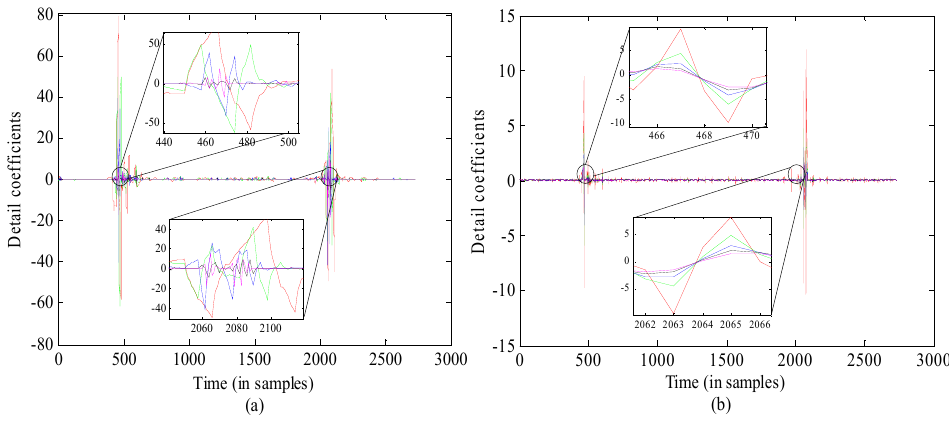
Figure 9. The detail coefficients of each decomposition level: ( a ) wavelet transform (WT); ( b ) MRSVD.